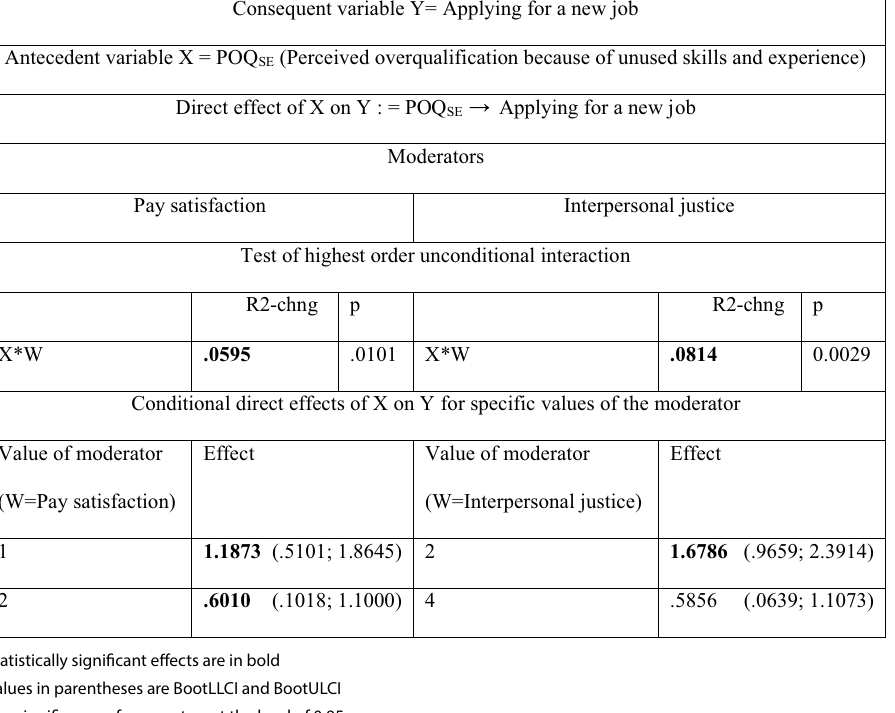
Table 5 Moderated direct effect of POQ (Perceived overqualification because of unused skills and experience) on Applying for a new SE job with the following moderators: Pay satisfaction and Interpersonal justice (respect from supervisors) Consequent variable Y= Applying for a new job Antecedent variable X = POQ SE (Perceived overqualification because of unused skills and